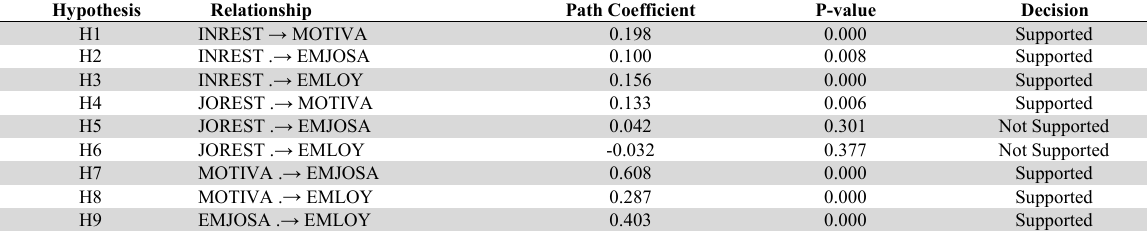
Path Coefficient and Hypothesis